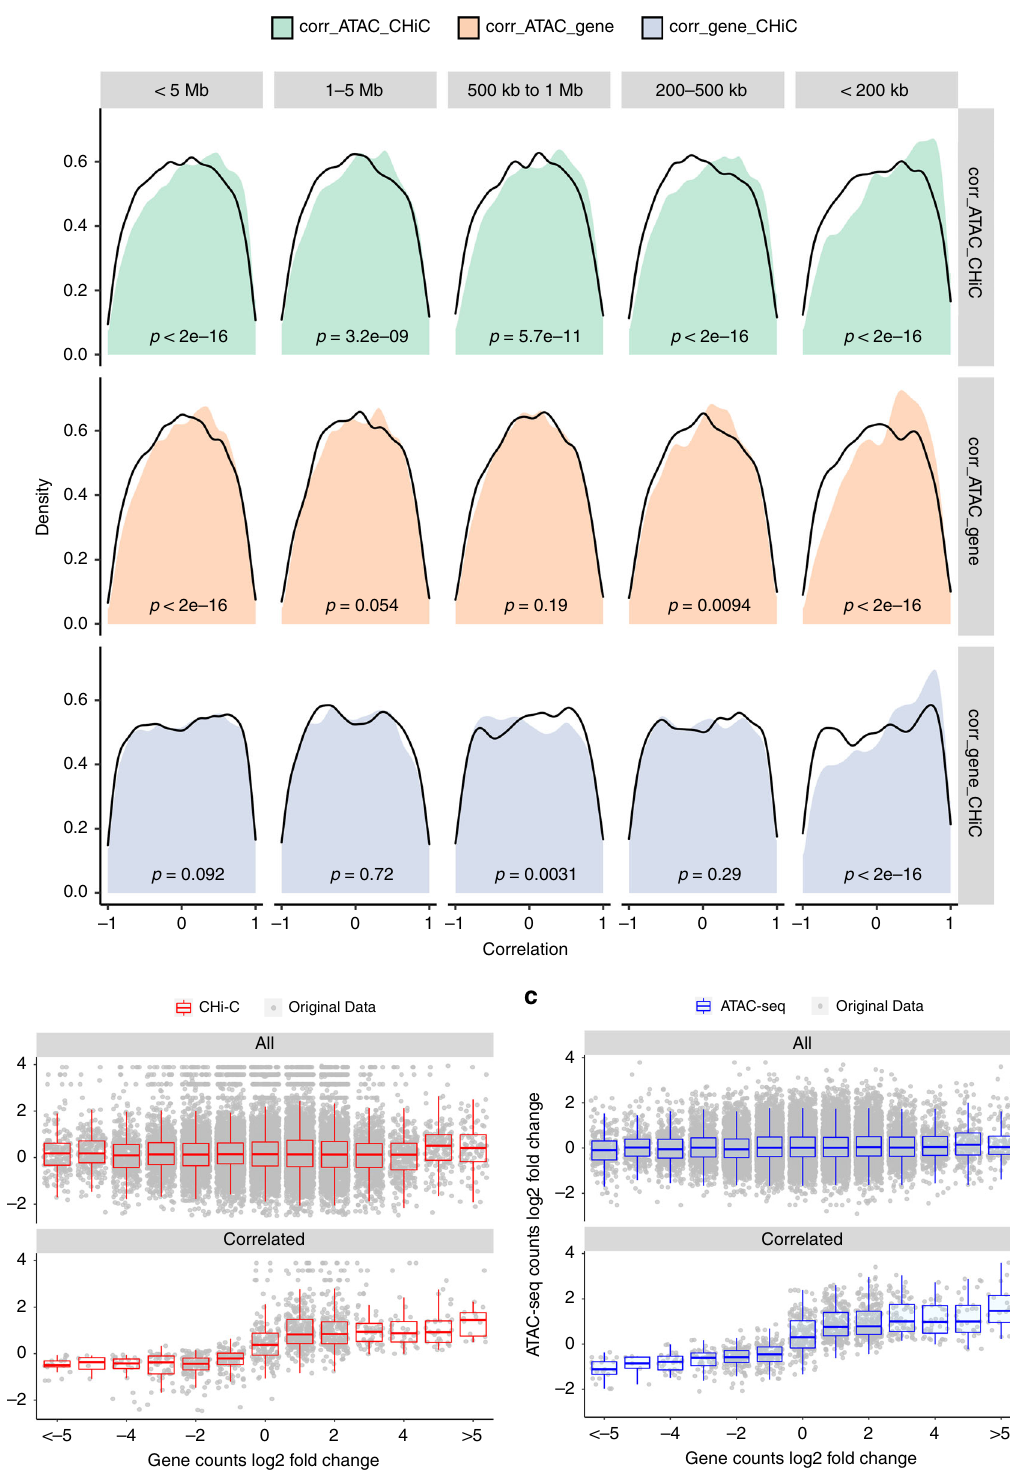
Fig. 4 Illustrations of the correlations between ATAC-seq, CHi-C and RNA-seq time course pro fi les. a Density plots of the Pearson correlation coef fi cients between ATAC-seq and CHi-C, ATAC-seq and gene and gene and CHi-C under various distance ranges around promoters. Distances ranges include those <5 Mb, between 1 and 5 Mb, between 500 kb and 1 Mb, between 200 and 500 kb and <200 kb. Black lines represent the density plots of the corresponding random background. P values from Wilcoxon tests are labelled in each panel with sample sizes of 27,805, 8229, 4742, 7942 and 6892 for categories< 5 Mb, 1 – 5 Mb, 500 kb – 1 Mb, 200 – 500 kb and <200 kb, respectively. b Comparison of the log2 fold change between CHi-C and gene data for all data set (upper) and those highly correlated ones with Pearson correlation coef fi cients between ATAC-seq, gene and CHi-C over 0.5 (lower). c Comparison of the log2 fold change between ATAC-seq and gene data for all data sets (upper) and those highly correlated ones with Pearson correlation coef fi cients between ATAC-seq, gene and CHi-C over 0.5 (lower). Box plot shows the median, the interquartile range (IQR) and Turkey whiskers (±1.5 times